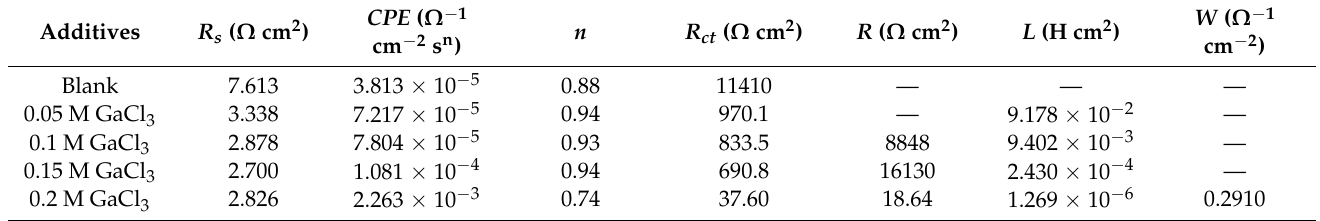
Table 4. Impedance fitting values of Al in 2 M NaCl electrolyte without and with different content of GaCl 3 additives.